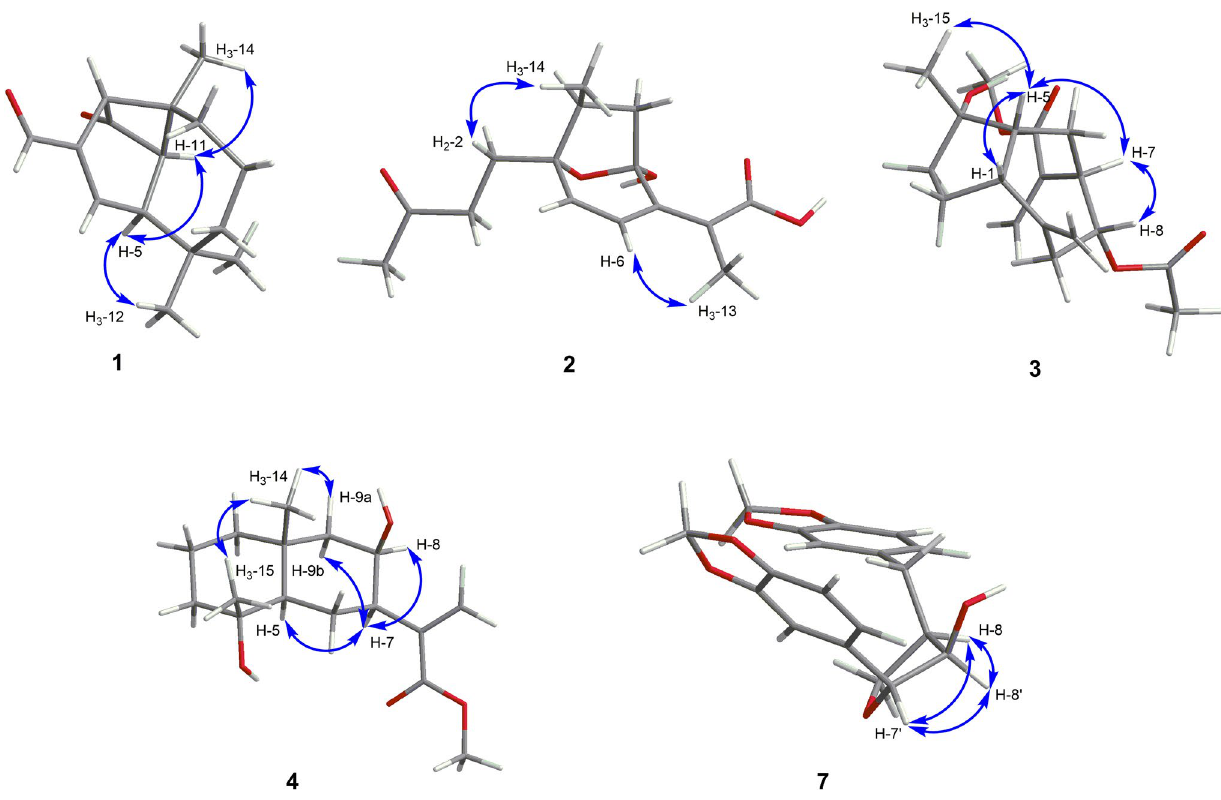
Fig. 4 Key ROESY correlations of compounds 1 – 4 and 7